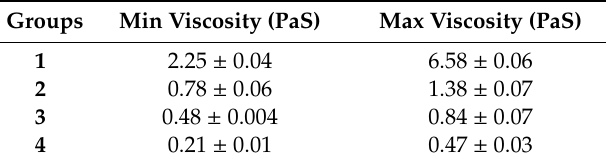
Table 1. Viscosity behavior for di ff erent groups.